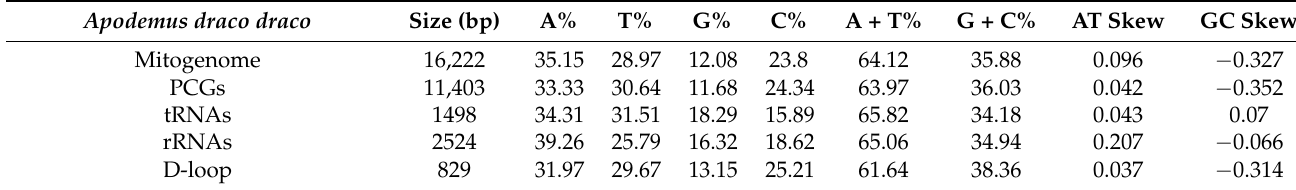
Table 4. Base content of the mitochondrial genome of Apodemus draco draco .